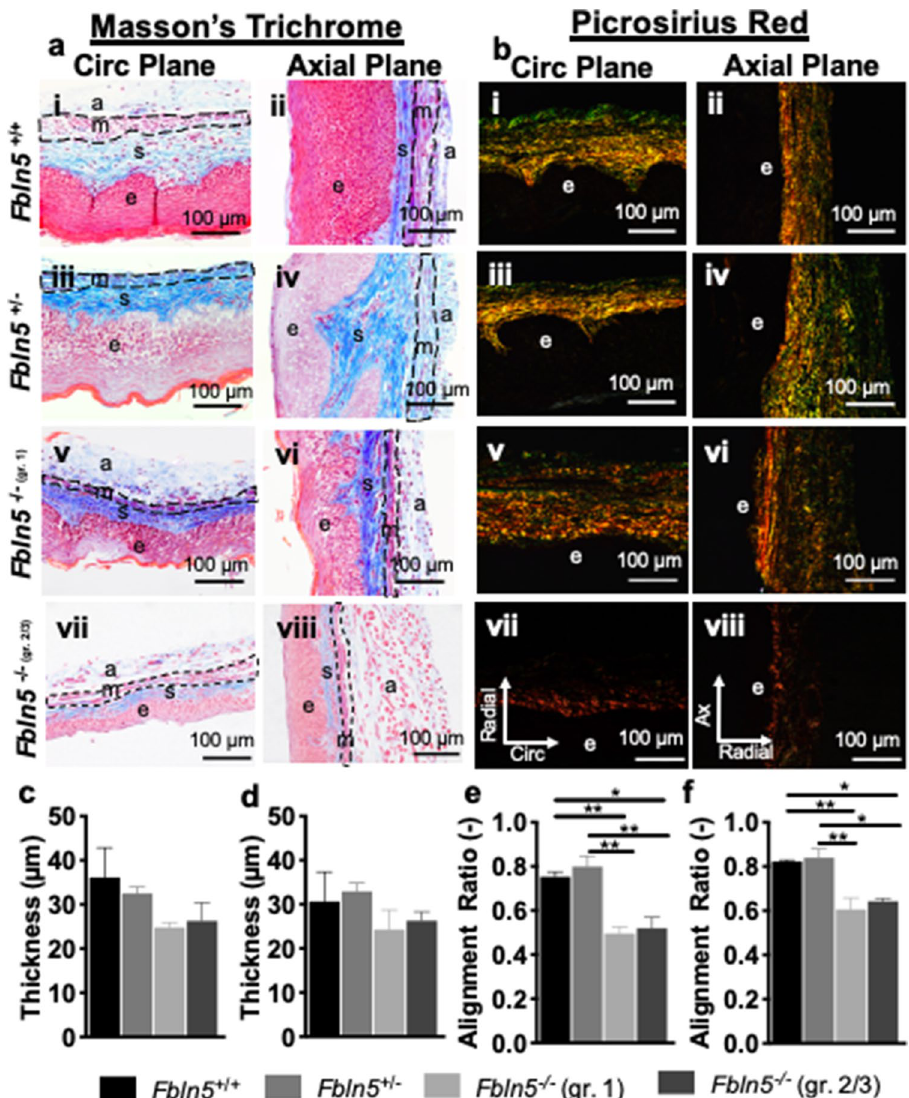
Figure 7. Muscularis thickness and collagen organization. Representative 40 × histological images of Masson’s Trichrome ( a ) and Picrosirius Red ( b ) stains along the circumferential (i, iii, v, vii) and axial (ii, iv, vi, vii) planes in the Fbln5 +/+ (i, ii), Fbln5 +/− (iii, iv), Fbln5 -/- with grade 1 POP (v, vi), and Fbln5 -/- with grade 2/3 POP (vii, viii) mice. The muscular layer is outlined with a black dashed line. Vaginal muscularis thickness is reported along the circumferential ( c ) and axial ( d ) planes for the Fbln5 +/+ (black; n = 3), Fbln5 +/− (grey; n = 3), Fbln5 -/- with grade 1 POP (light grey; n = 3), and Fbln5 -/- with grade 2/3 POP (dark grey; n = 3) mice. Collagen alignment ratio is reported along the circumferential plane ( e ). Fibulin-5 insufficiency and POP significantly affected collagen fiber alignment ratio along the circumferential plane (p < 0.001). The alignment ratio decreased in the Fbln5 −/− vagina with grade 1 (p = 0.006) and 2/3 (p = 0.01) POP compared to the Fbln5 + / + . The alignment ratio decreased in the Fbln5 −/− vagina with grade 1 (p = 0.002) and 2/3 (p = 0.004) POP compared to the Fbln5 +/− . Collagen alignment ratio is reported along the axial plane ( f ). Fibulin-5 insufficiency and POP significantly affected collagen fiber alignment ratio along the axial plane (p = 0.002). The alignment ratio decreased in the Fbln5 −/− vagina with grade 1 (p = 0.008) and 2/3 (p = 0.02) POP compared to the Fbln5 + / + . The alignment ratio decreased in the Fbln5 −/− vagina with grade 1 (p = 0.005) and 2/3 (p = 0.01) POP compared to the Fbln5 +/− . Layers of the vagina are denoted as: epithelium (e), subepithelium (s), muscularis (m), and adventitia (a). Data is reported as mean ± SEM. Statistical significance is denoted by *p < 0.05 and **p <